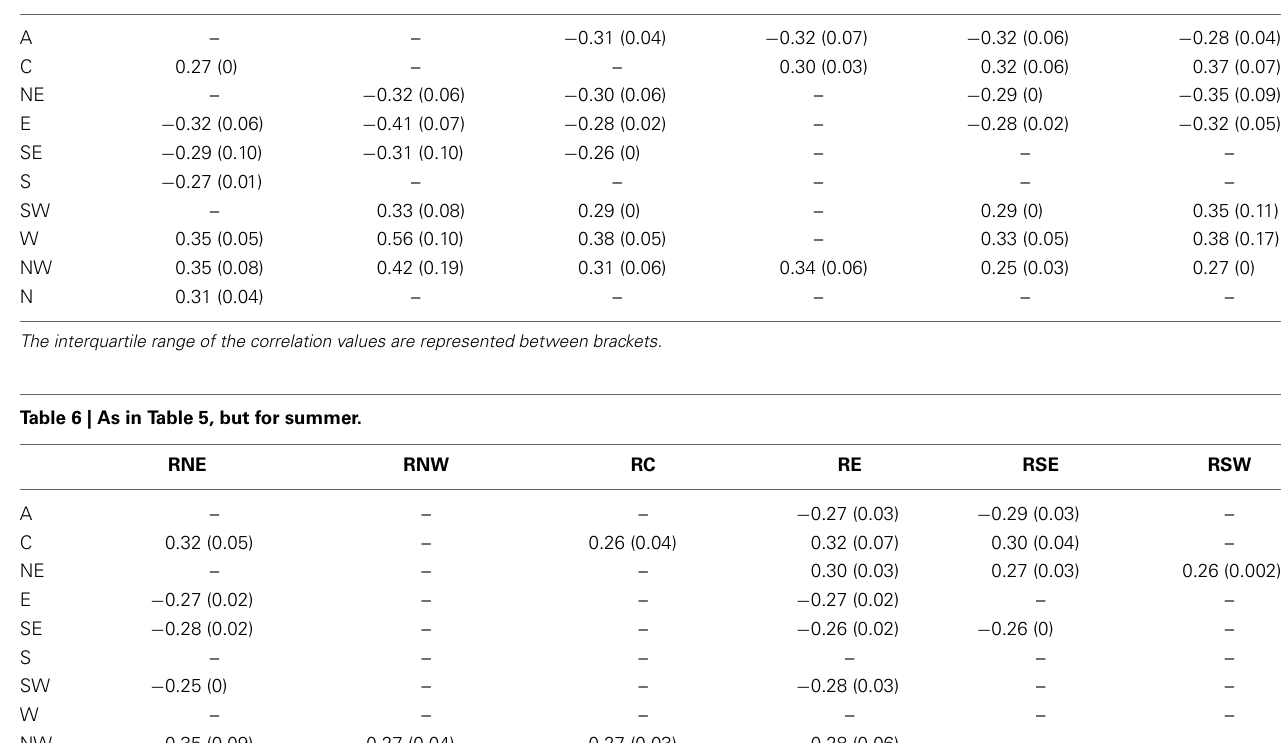
Table 5 | Median values of correlation between the weather-type frequency and the winter SPEI in the Iberian Peninsula (1950–2012). RNE